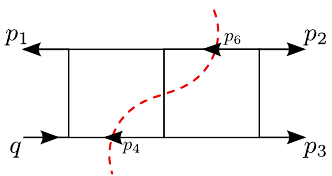
Figure 3 . One of the cuts of the maximal topology used to solve the s 23 -channel triple cut. Note that p 6 is part of a one-loop